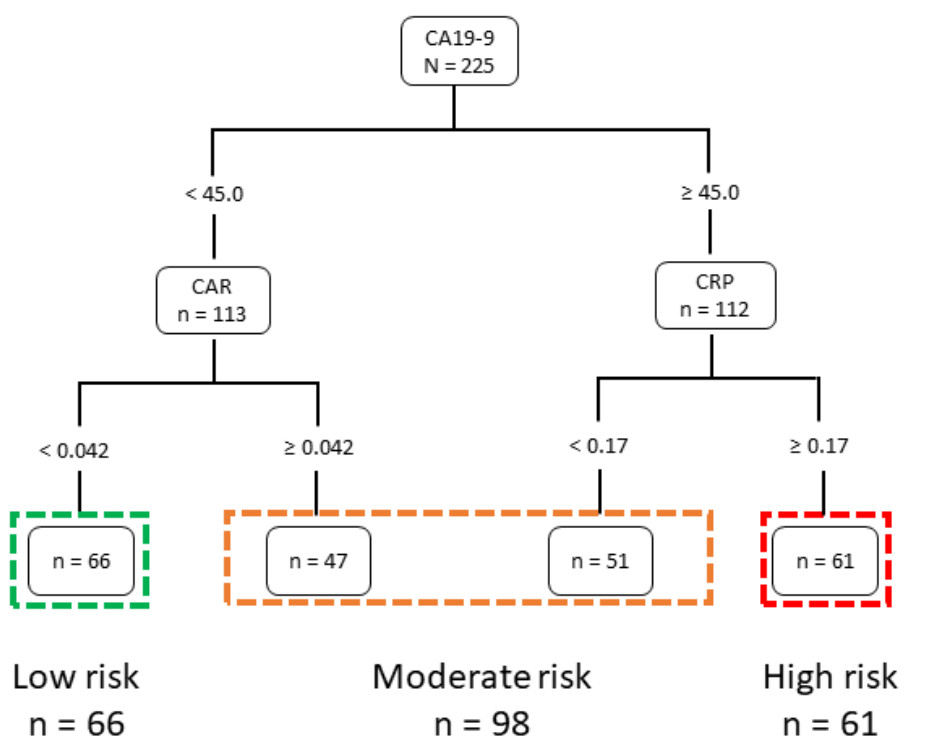
Figure 1. The decision tree model based on CA19-9, CAR, and CRP for predicting recurrence-free survival. CA19-9: carbohydrate antigen 19-9; CRP: C-reactive protein; CAR: CRP/albumin ratio. Table 1. Differences in clinical characteristics of 225 patients with intrahepatic cholangiocellular carcinoma classified into three risk groups by preoperative markers.